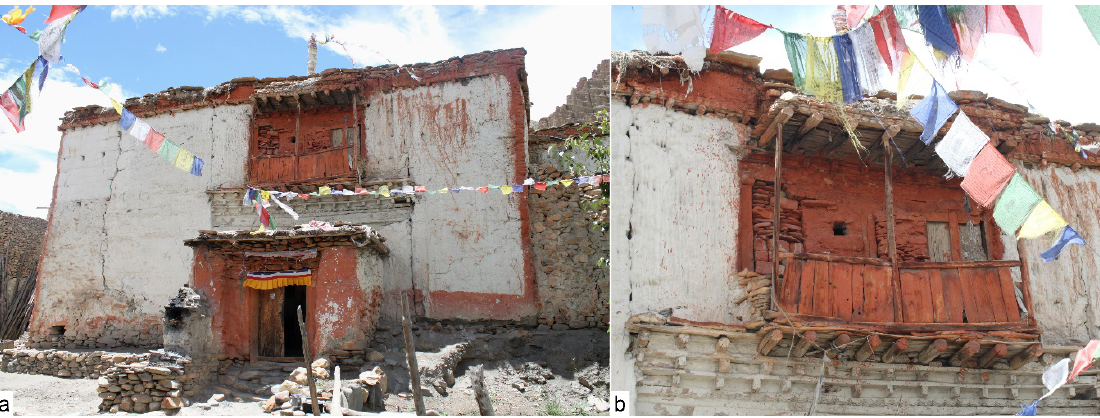
Figure 3. Gönpa Gang: ( a ) eastern façade; ( b ) balcony with a large rabsal window above the